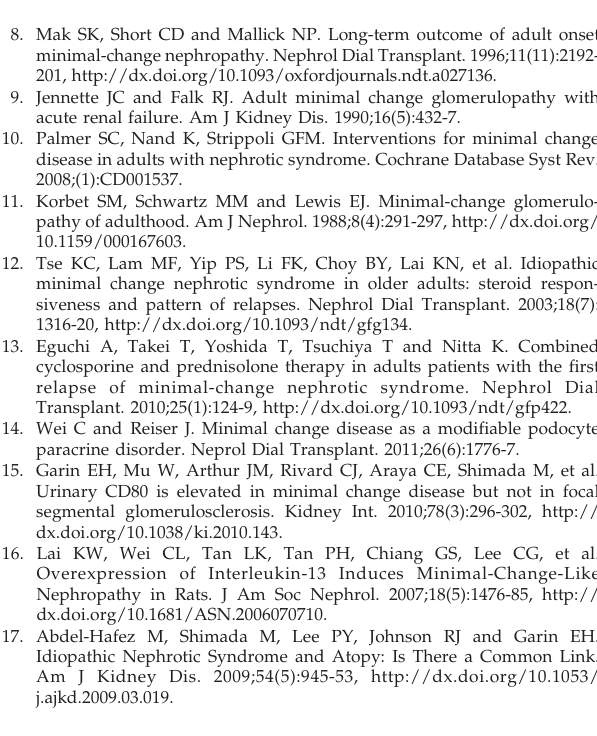
Figure 1 - Outcome after